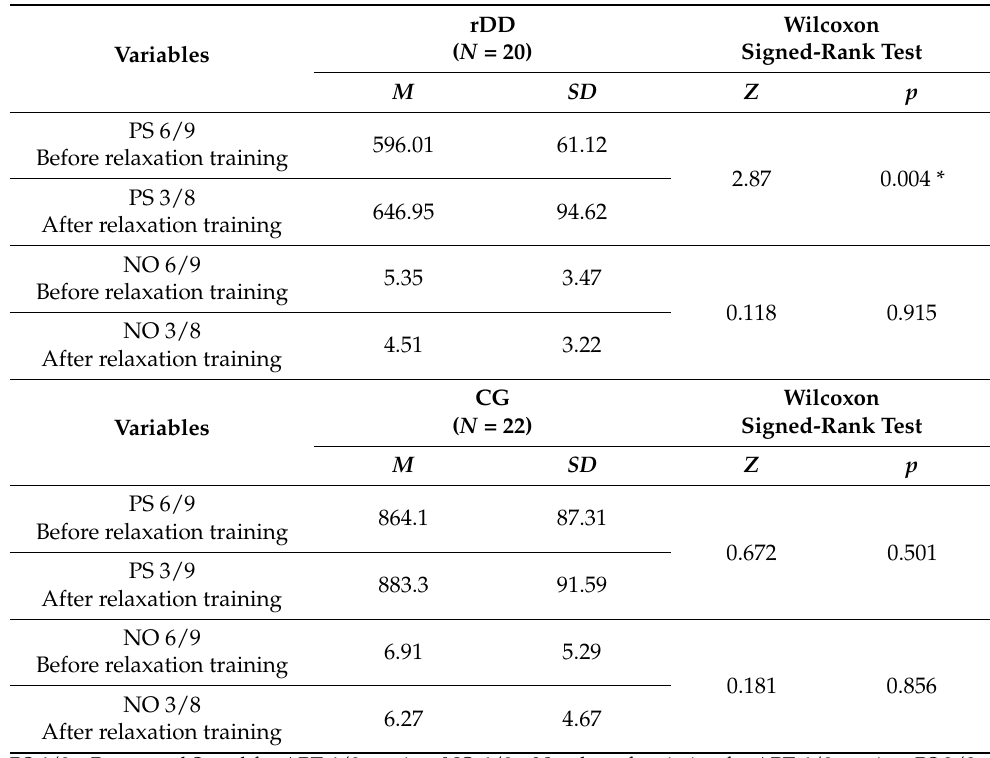
Table 3. Comparison of the level of performance of the two parts of the APT test before and after relaxation